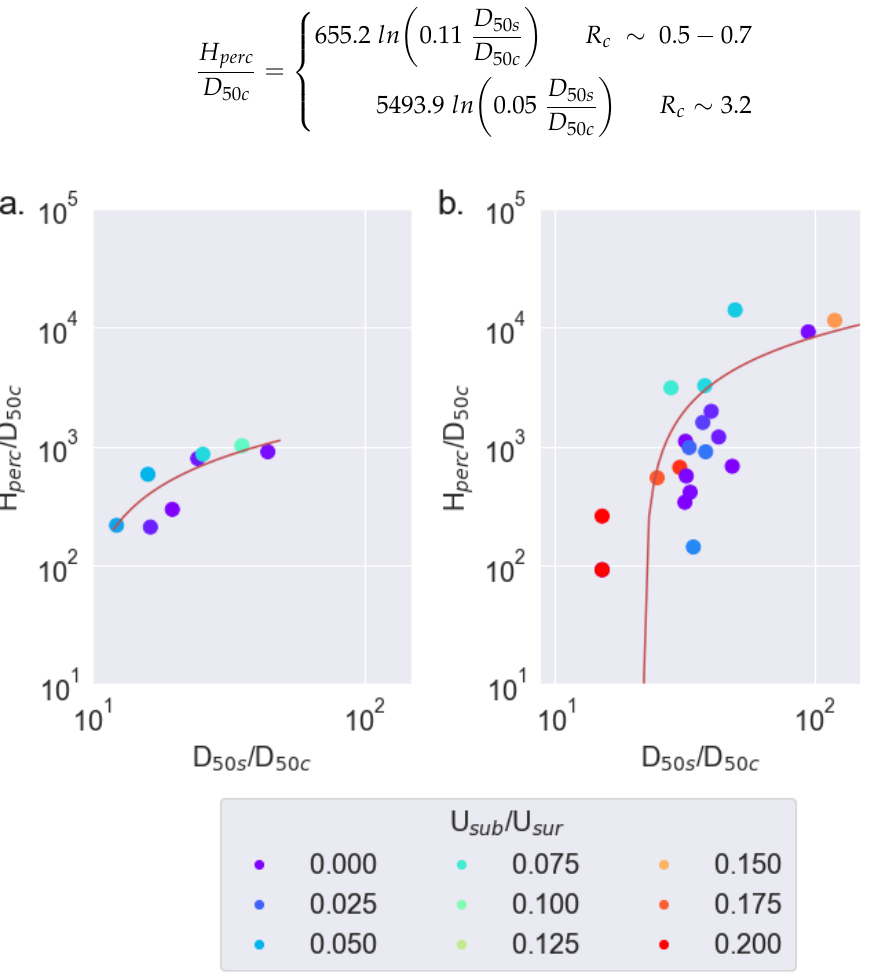
Figure 9. Maximum dimensionless infiltration of fine sediment into the substrate as function of the relative submerged density, R c , and D 50 s / D 50 c . Red lines represent the logarithmic trend between H perc / D 50 c and D 50 s / D 50 c , for ( a ) R c ∼ 0.5–0.7 and ( b ) R c ∼